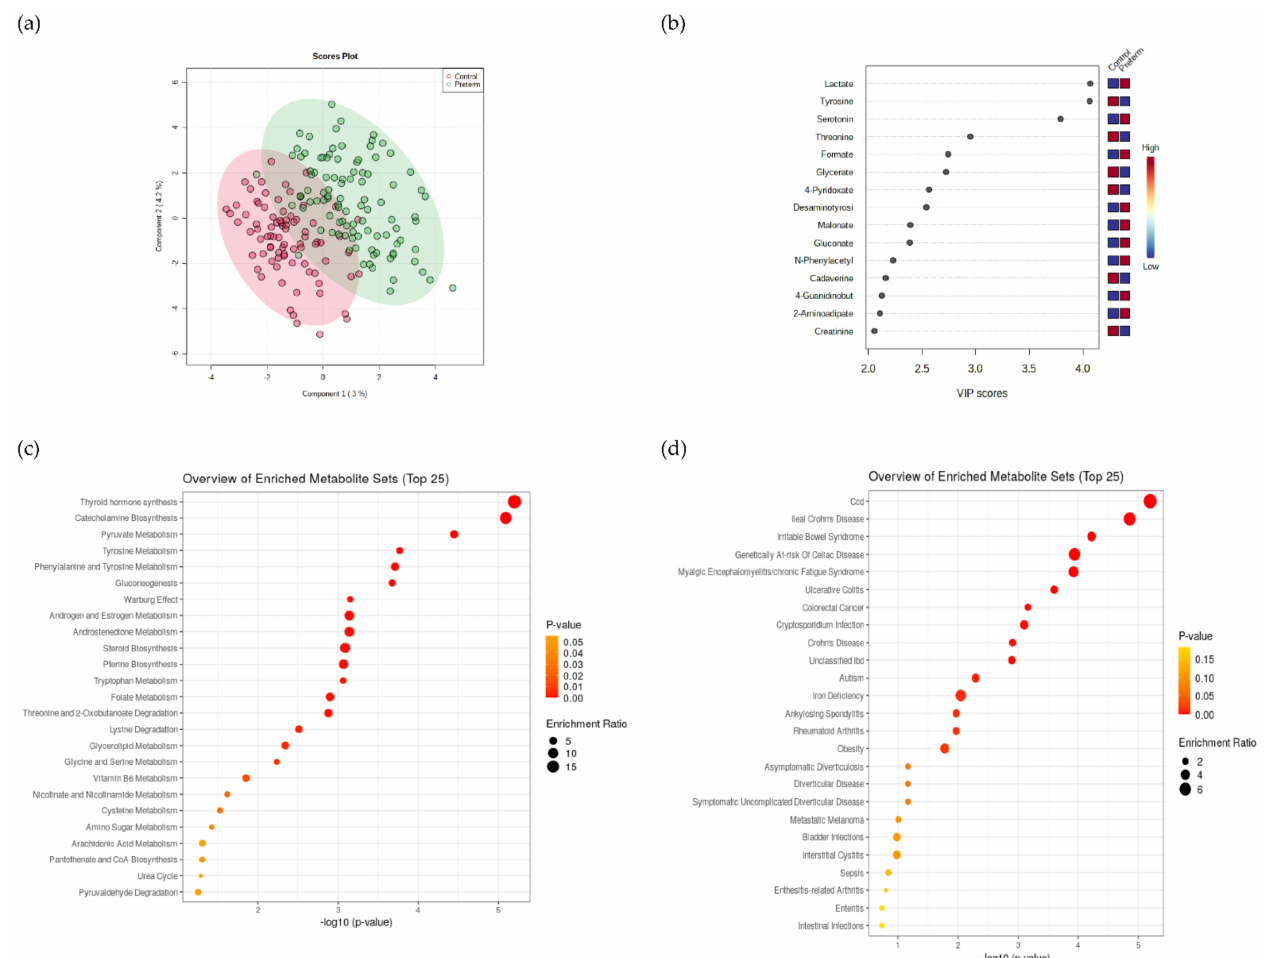
Figure 3. ( a ) Fecal metabolomes comparing preterm and full-term born adults and the most differen- tiating metabolites based on the PLSDA method ( b ). The most enriched pathways associated with metabolism ( c ) and diseases ( d ) based on fecal metabolomes. Enlarged ( c , d ) figures were added to supplementary (Figures S7 and